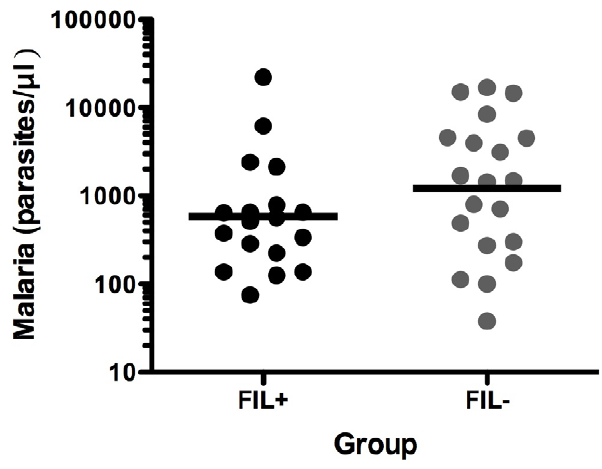
Figure 3. Time to first episode of clinical malaria. The cumulative % of FIL + (black line) and FIL 2 (gray line) subjects who had experienced at least one episode of malaria is shown for each week of the first transmission season (estimated by Kaplan-Meier method to account for subjects who withdrew from the study).